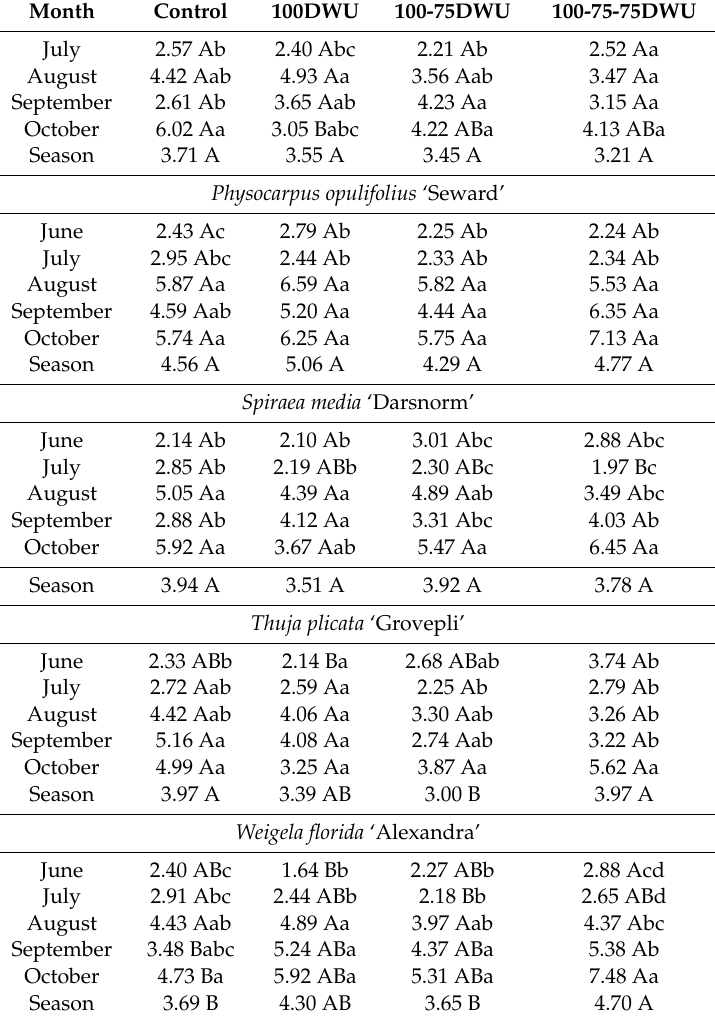
Table 4. Monthly crop coe ffi cient (K C or K Cadj ) for eight shrubs grown in 10.2 L containers under four irrigation treatments z from 23 June (Day 0) through 31 October (Day 131) 2010. Control